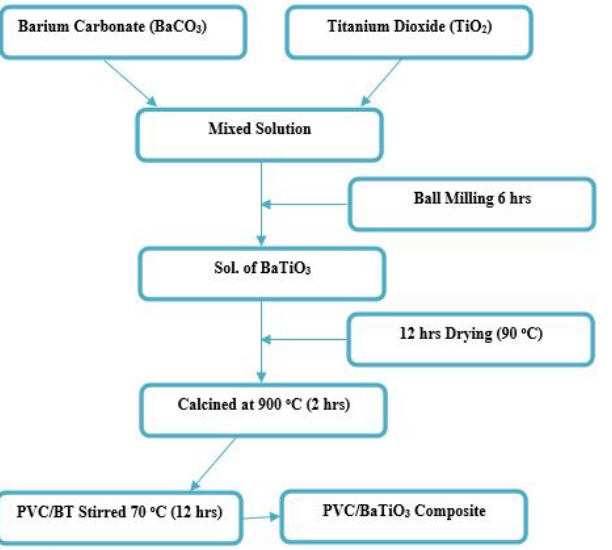
Figure 1. A schematic representation for the preparation of BT, PVC and PVC/BT composites. PVC/BaTiO 3 composite films were synthesized via the solution casting